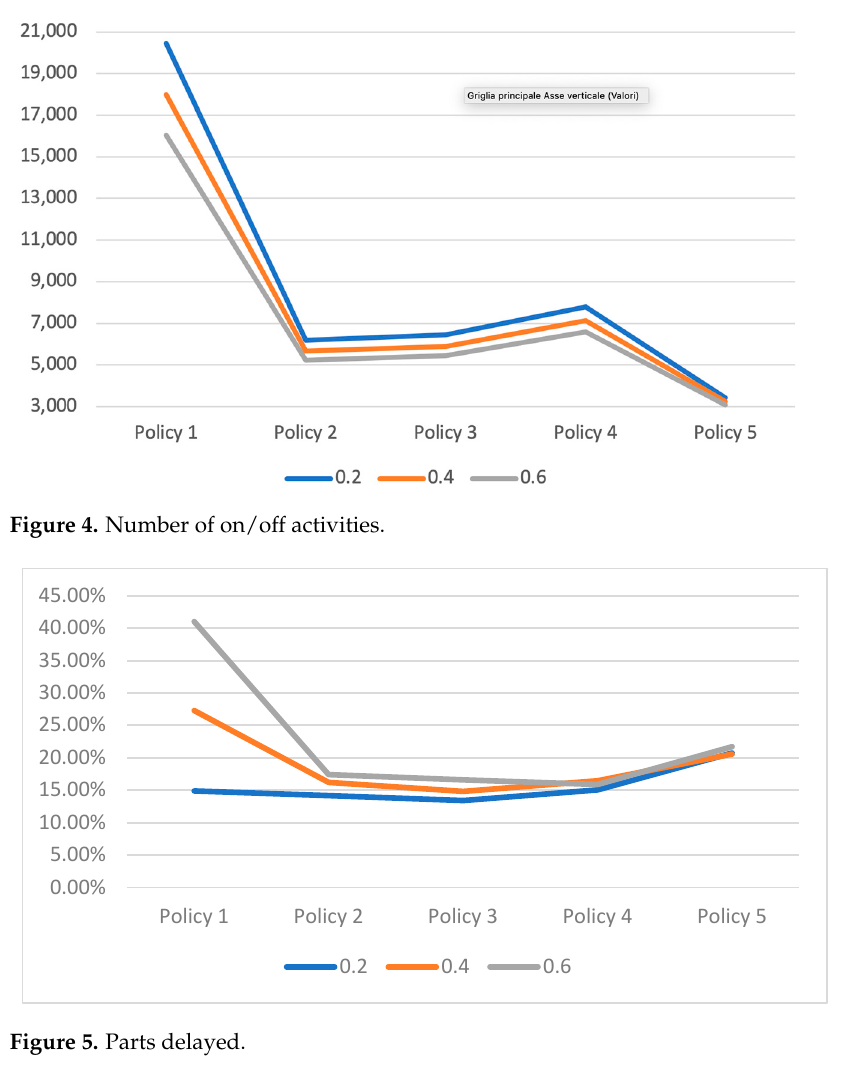
Figure 3. Main e ff ects.